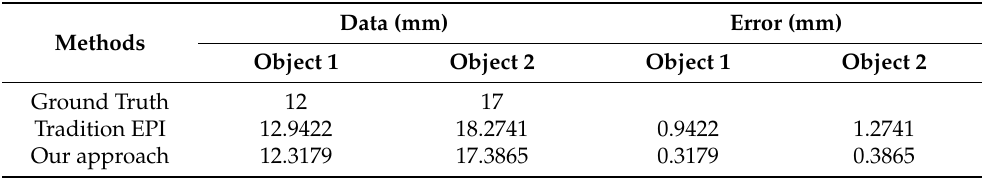
Figure 10. 3D reconstruction results of different methods. ( a ) traditional EPI for object 1; ( b ) our approach for object 1; ( c ) traditional EPI for object 2; ( d ) our approach for object 2.